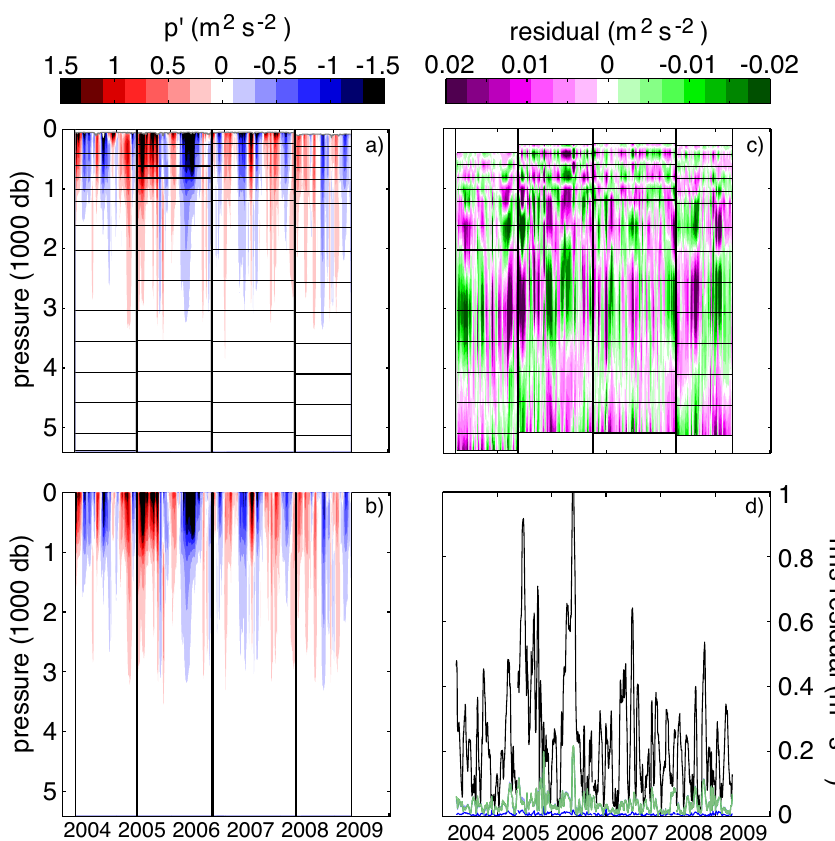
Fig. 3. An example reconstruction at WB5. (a) The original reduced pressure perturbation (in color), with median instrument depths (hor- izontal black lines) over each deployment. (b) The reconstructed reduced pressure perturbation using all 5 flat-bottomed modes. (c) The residual of the fits at constant depth levels over each deployment (note the enlarged color scale). (d) The vertical rms of the original signal (black), and the vertical rms residual of the reconstructed signal using all flat-bottomed modes (blue), using 2 flat-bottomed modes (light blue, obscured by green), and using 2KB modes (green). Different deployment periods are delineated by vertical